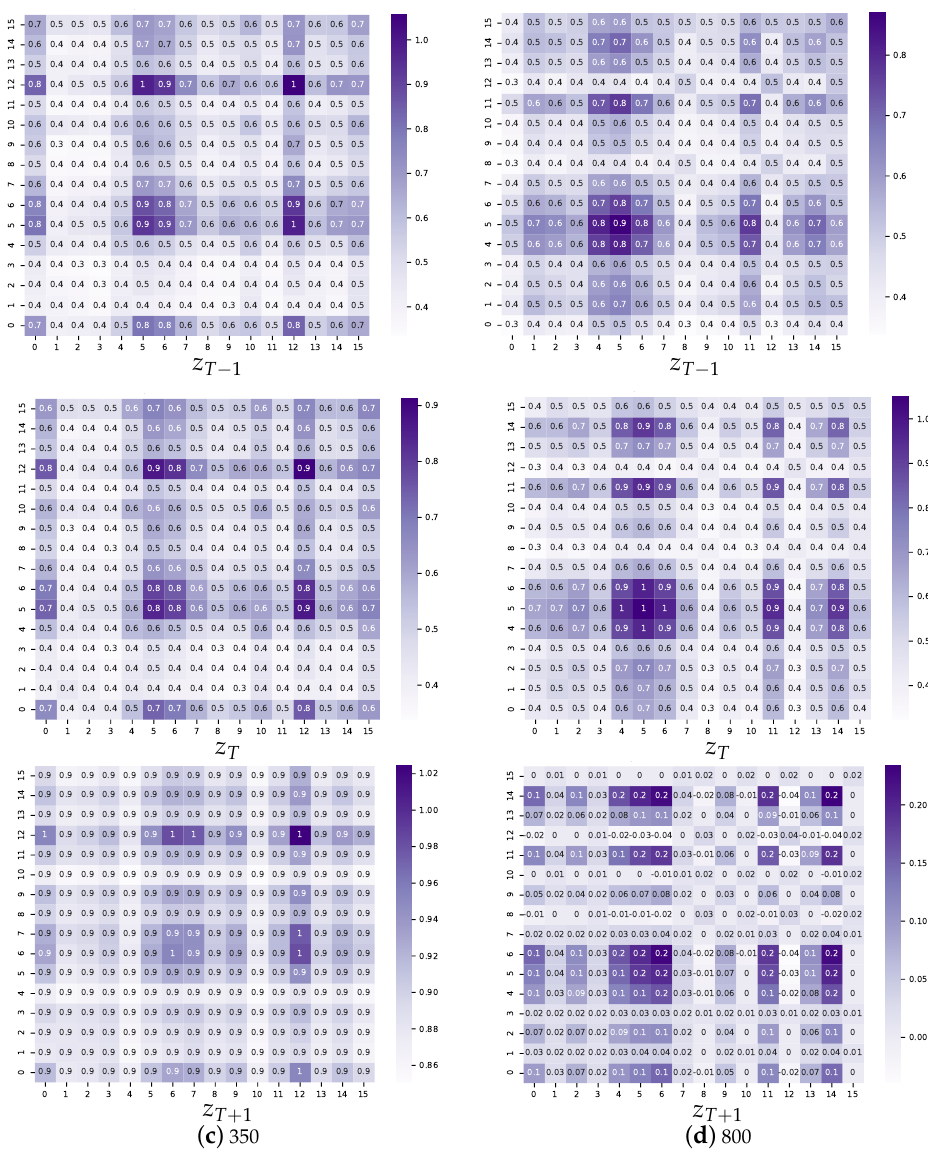
Figure A2. The covariance matrices for all the states for the